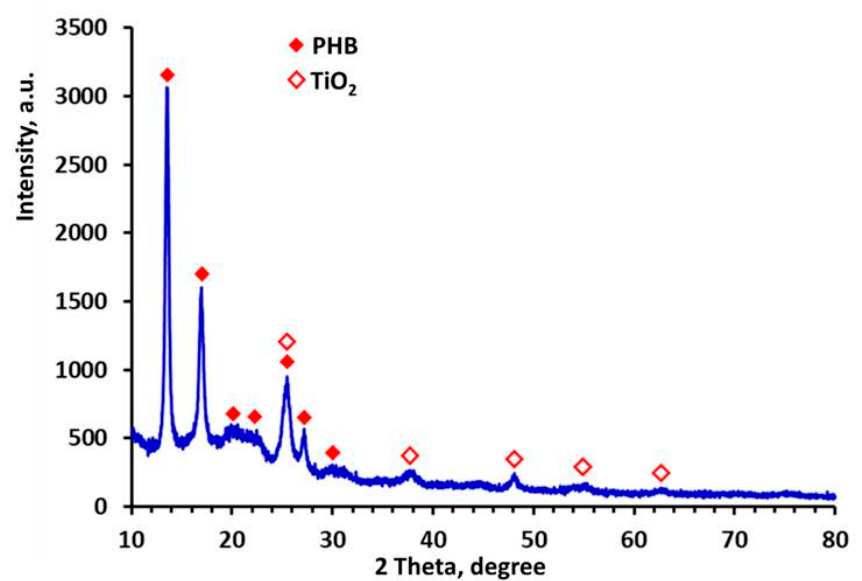
Figure 6. XRD pattern of fibrous materials: TiO 2 - in -PHB.